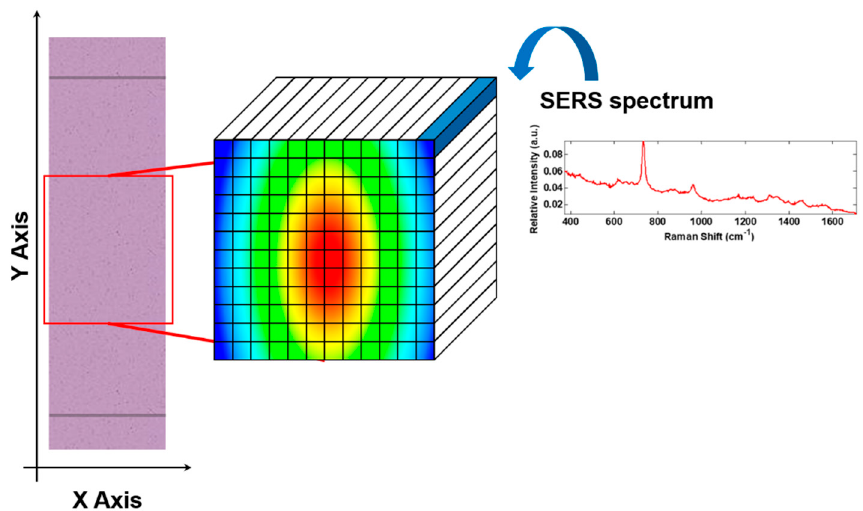
Figure 2. Schematic representation of a hyperspectral image of a TLC